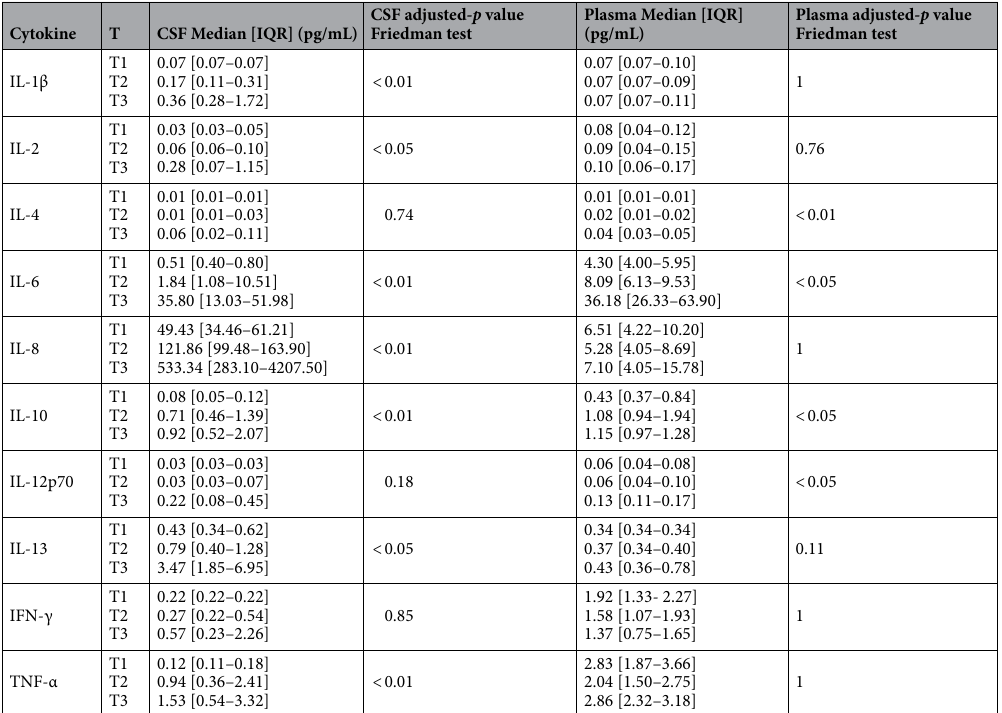
Table 2. Summary of cytokine measurements in plasma and CSF. Cytokine levels in plasma and CSF before surgery (T1), immediately after surgery (T2) and the day after surgery (T3).